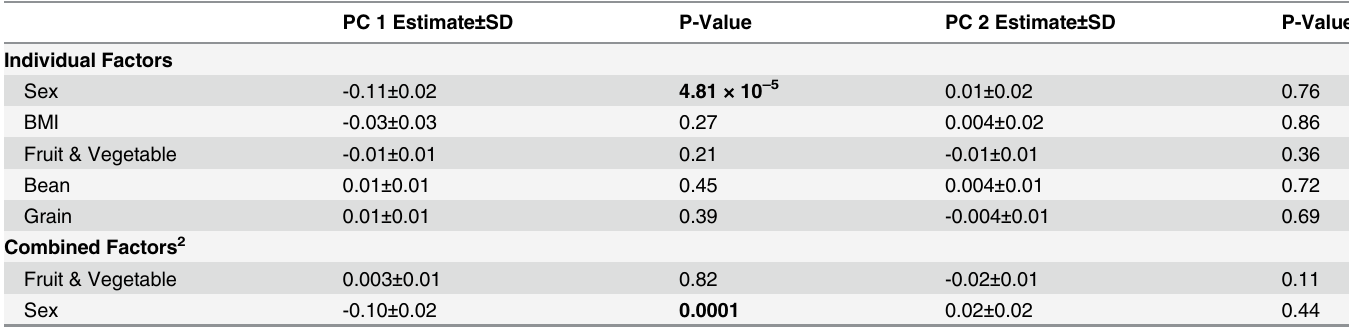
Table 3. Univariate and multivariate linear regressions 1 for personal factors and unweighted principal coordinates